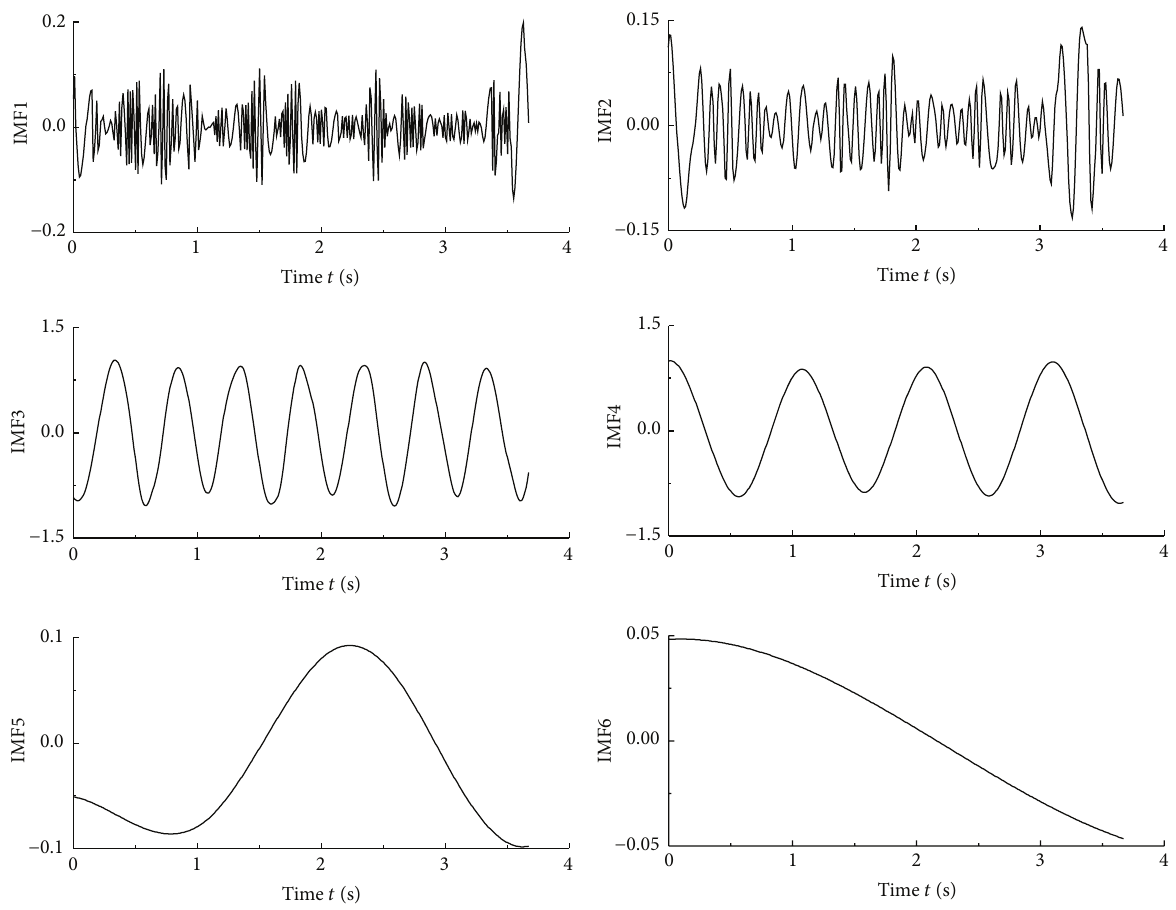
Figure 6: Improved EMD analysis results of the simulated signal 𝑧(𝑡) .